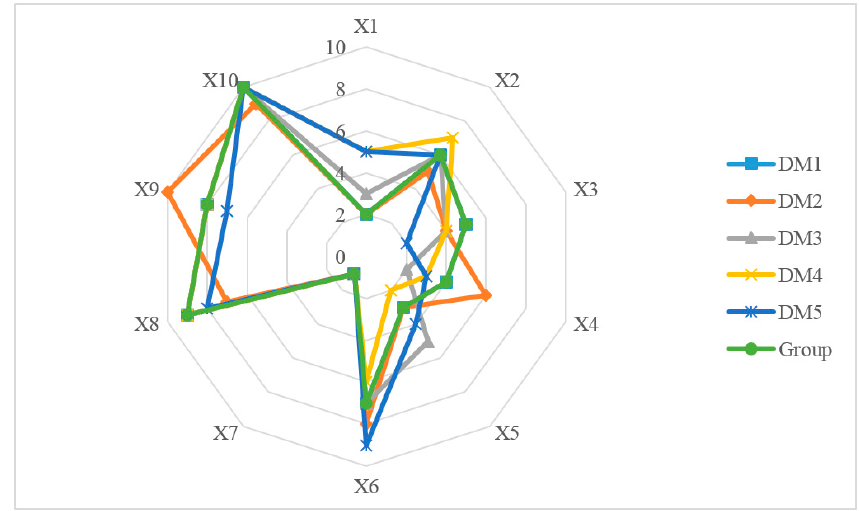
Figure 7. The individual ranking and group ranking for 10 mobile medical APPs based on UMLV- Technique for Order of Preference by Similarity to Ideal Solution (TOPSIS).